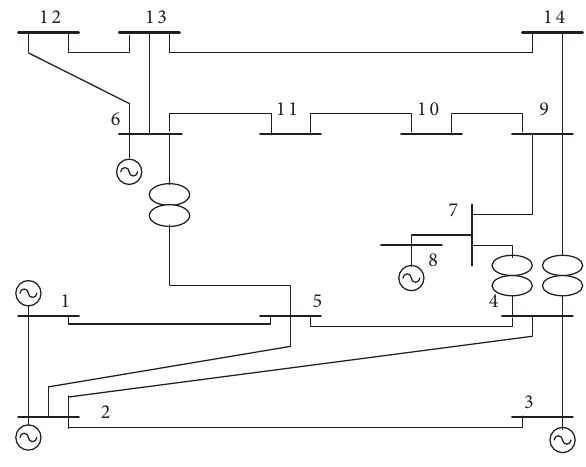
Figure 4: Single line diagram of an IEEE 14-bus